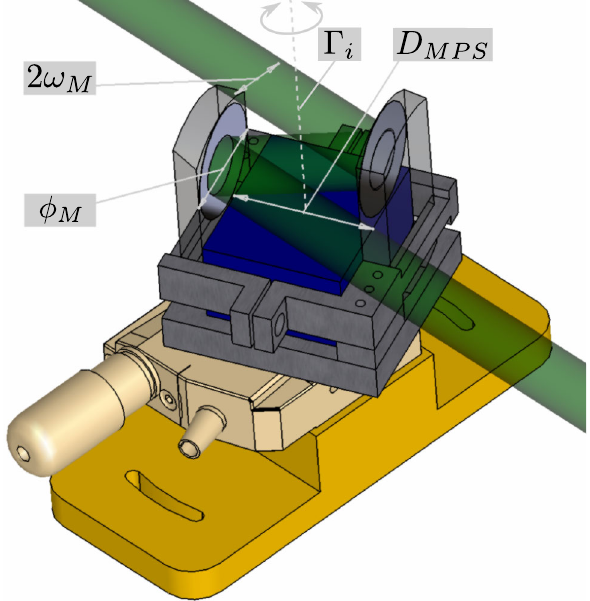
FIG. 3. Isometric view of the i th mirror-pair system and the laser beam path (green line) reflecting on the two parallel mirrors spaced by D MPS